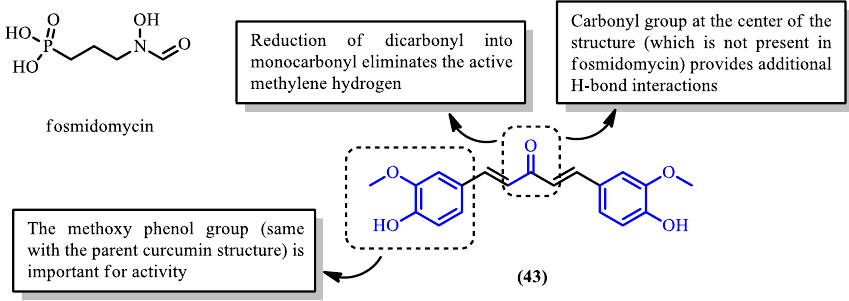
Figure 19. Targeted structural modification sites of monocarbonyl curcumin derivatives.